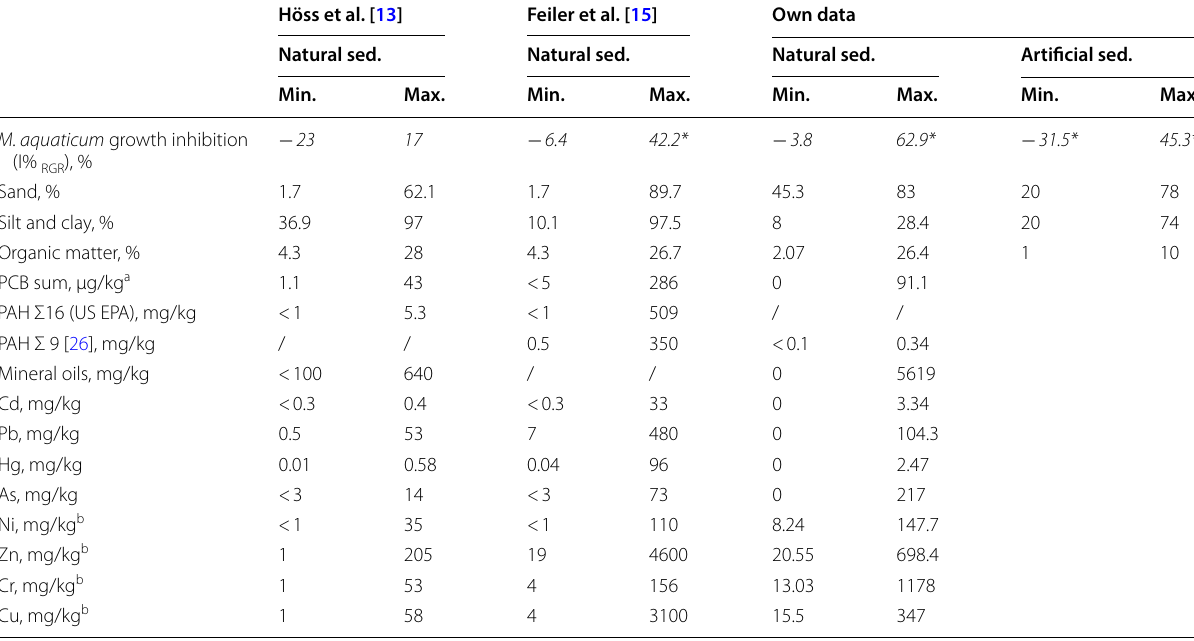
Table 6 Minimum and maximum values of M. aquaticum growth inhibitions, geochemical and chemical properties of tested sediments in the present and cited studies [13,